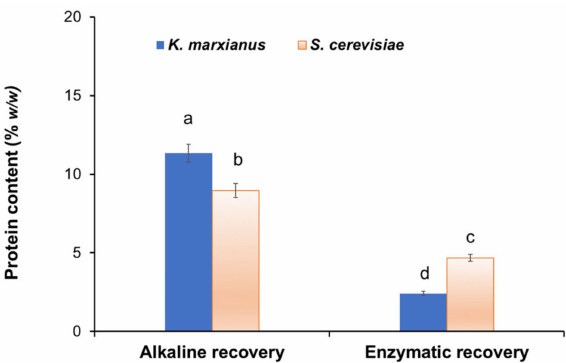
Figure 3. Protein contents in aqueous solution after recovery of BG at the optimum conditions. Different letters a–d indicate statistically significant differences ( p < 0.05) according to Duncan’s multiple range test. Error bars show mean ± SD ( n =